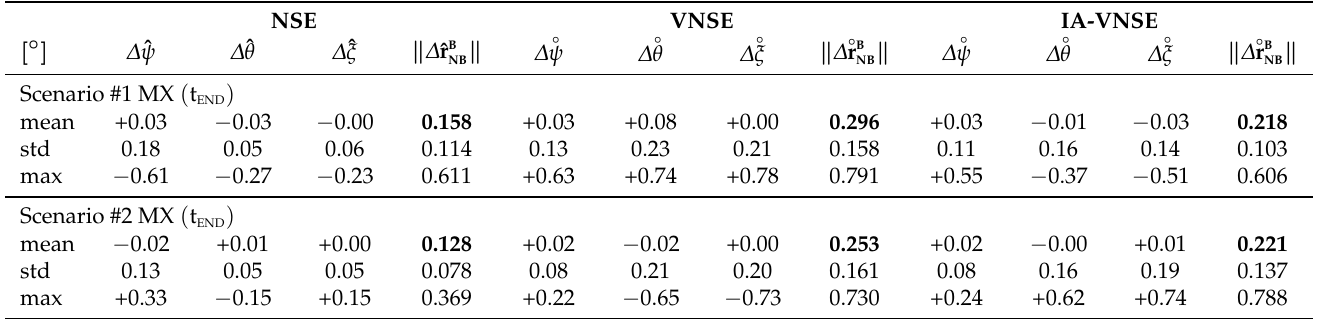
Table 4. Aggregated MX final body attitude INSE, VNSE, and IA-VNSE (100 runs). The most important metrics appear in